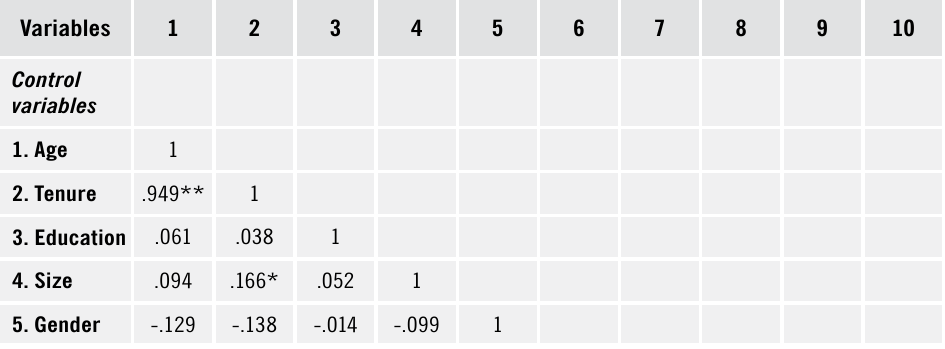
Table 2. Convergent and discriminant